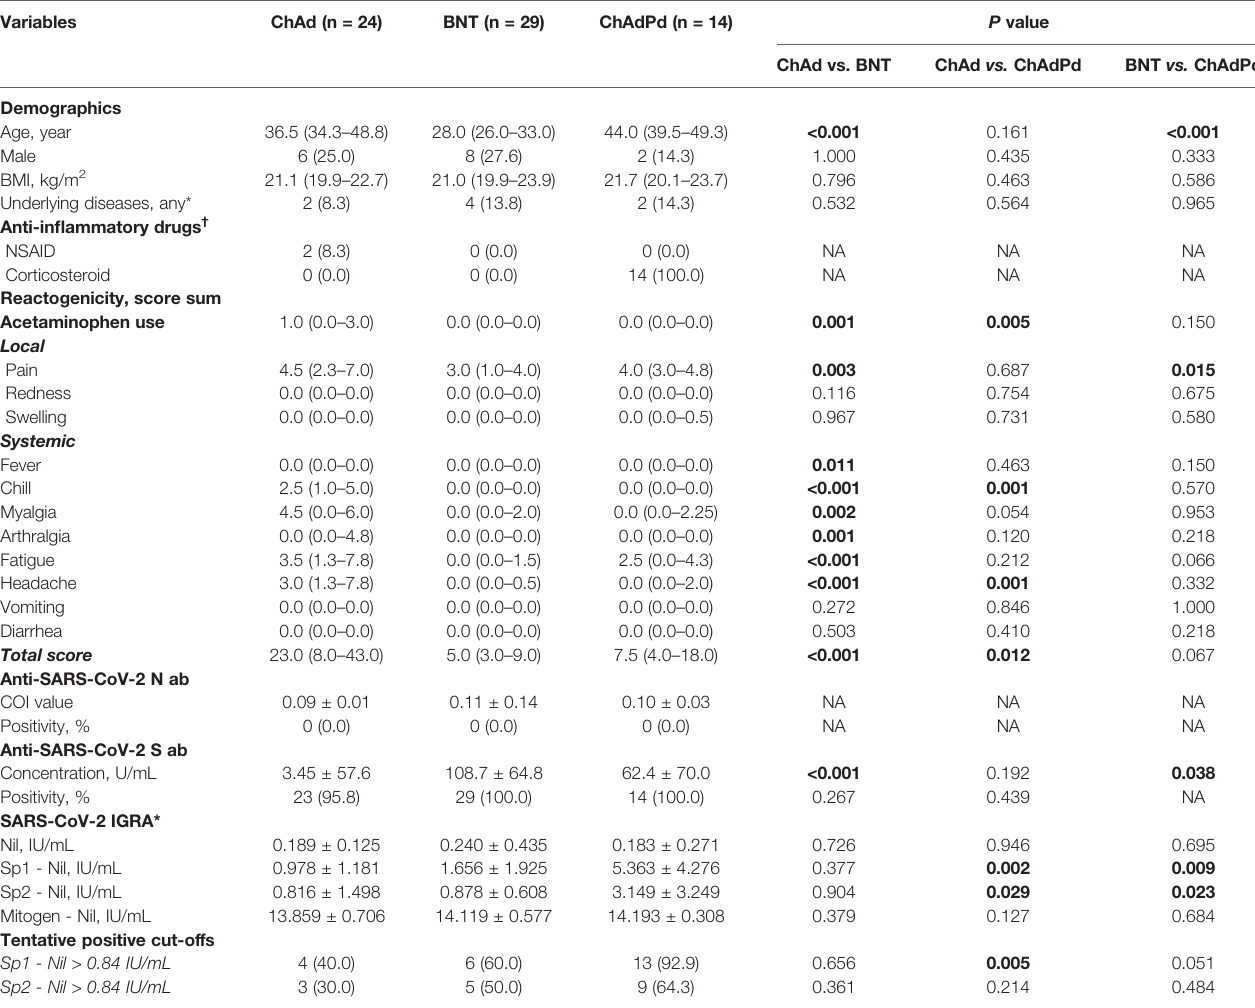
TABLE 1 | Baseline characteristics, reactogenicity, and immunogenicity of vaccinated HCWs.